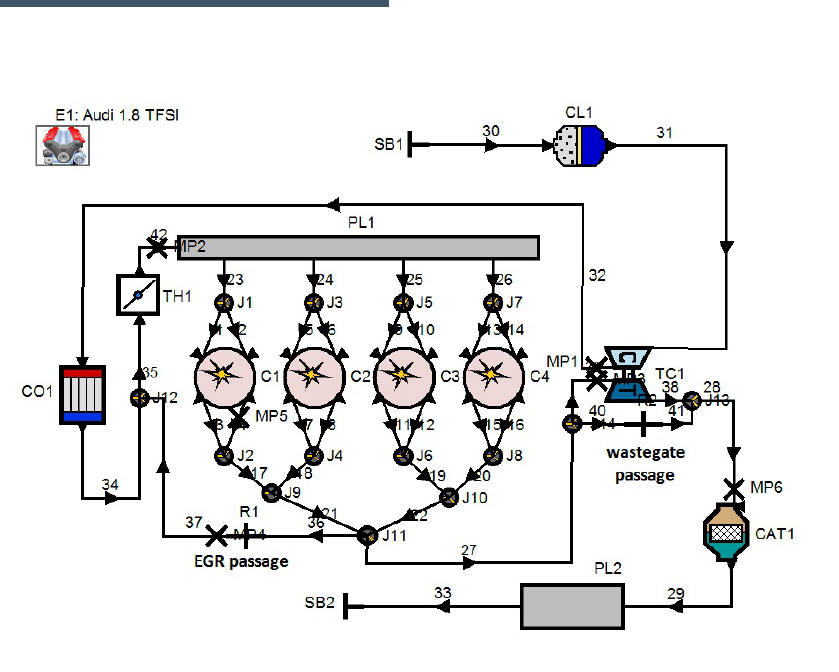
Figure 4. AVL Boost turbocharged engine layout.